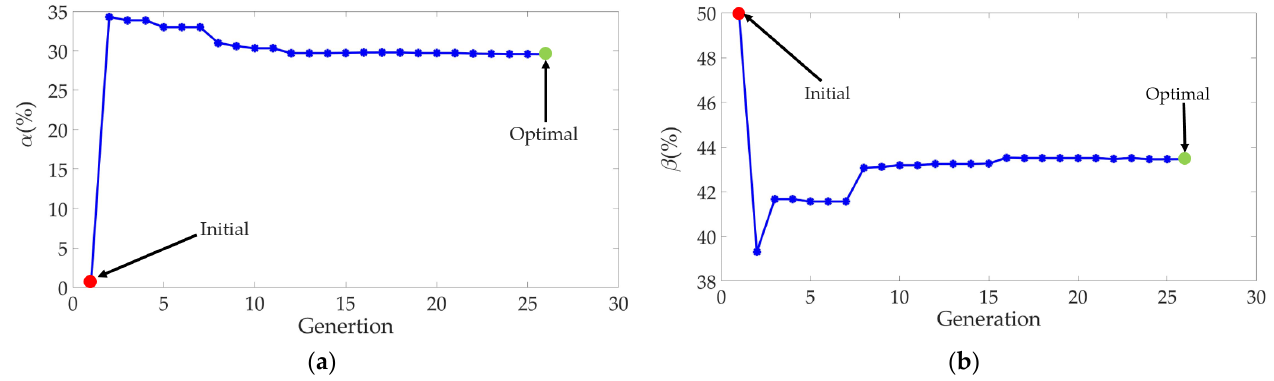
Figure 23. Optimization history. ( a ) Evolution of 𝛼 over generations. ( b ) Evolution of 𝛽 over generations.